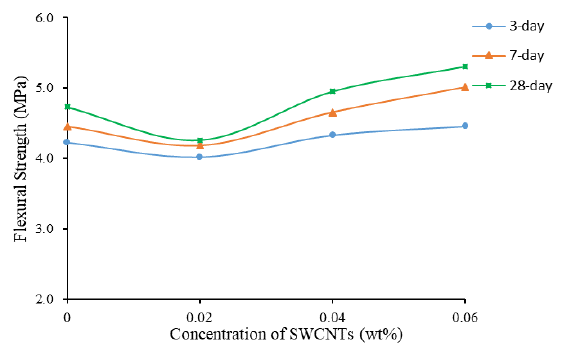
Figure 10. Flexural strength as a function of concentration of SWCNTs (TX10).